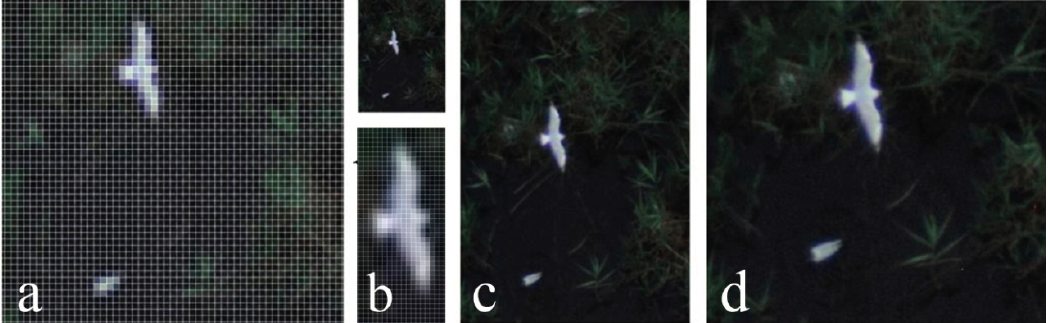
( c ) black-headed gulls at the 1 cm spatial resolution; and ( d ) black-headed gulls at the 0.5 cm spatial